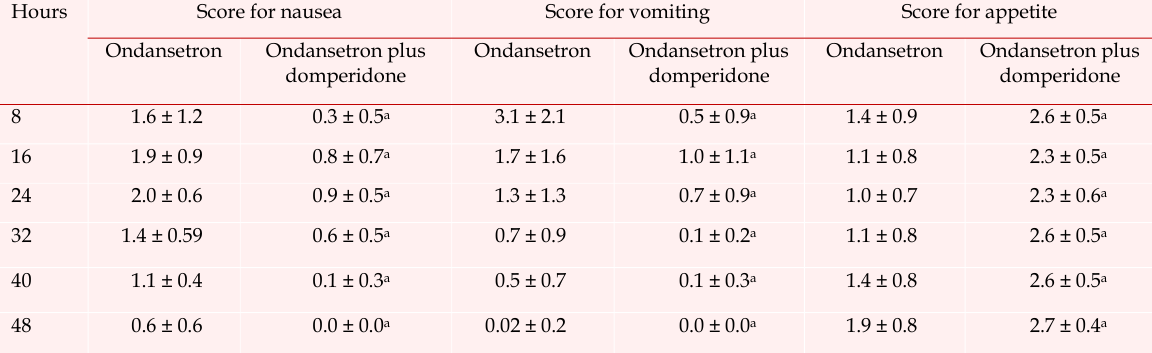
Effect of ondansetron administered alone and in combination with domperidone on